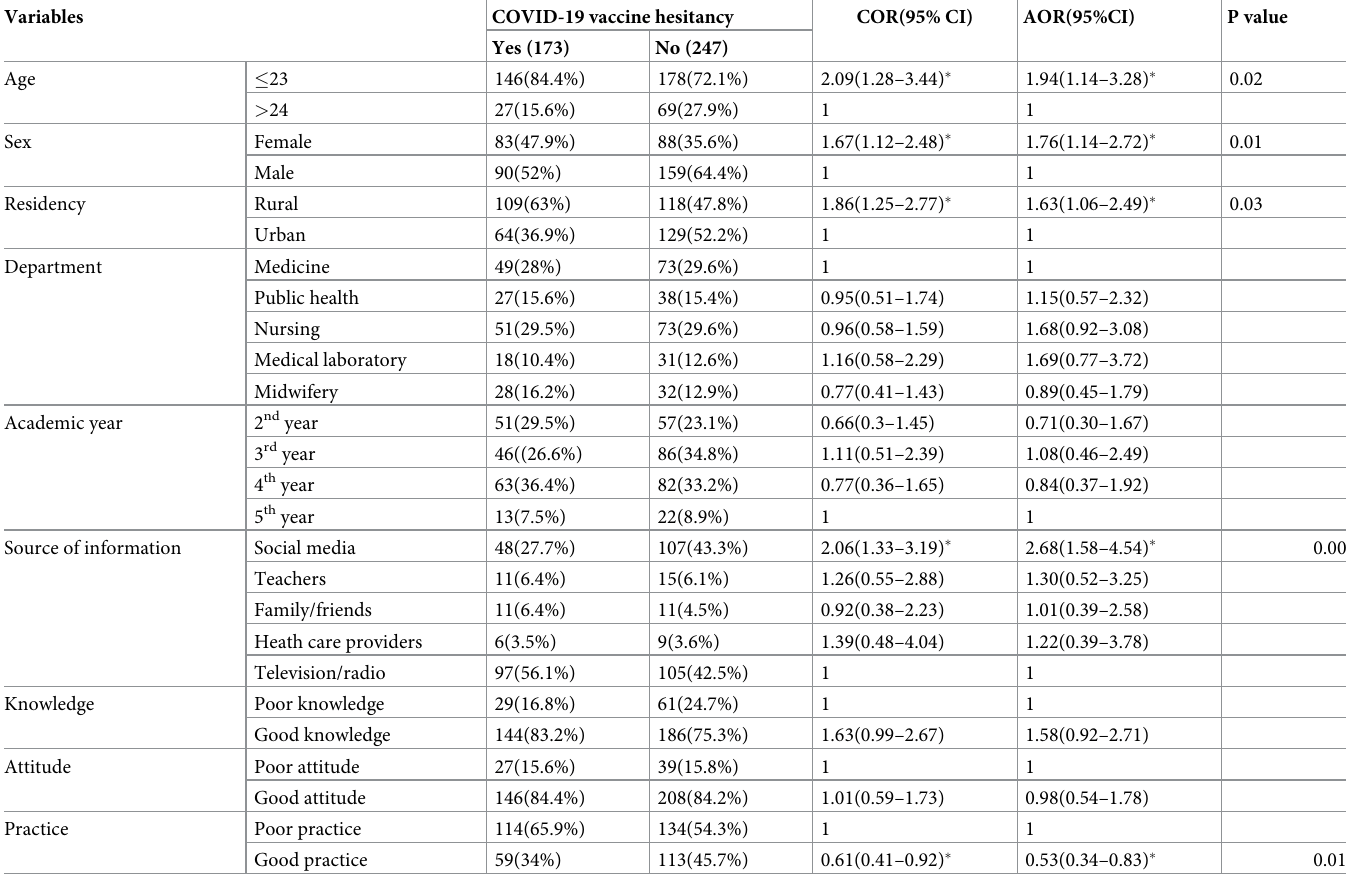
Table 5. Bivariate and multivariate logistic regression analysis of factors associated with COVID-19 vaccine hesitancy among medical and health science students of Wolkite University, Ethiopia, 2021 (n =